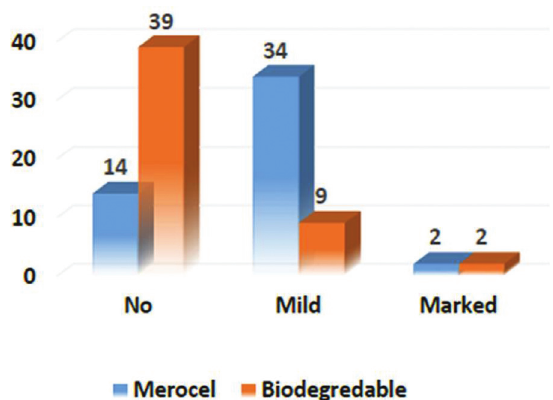
Bar chart illustrating postoperative blood loss while the packing in place.